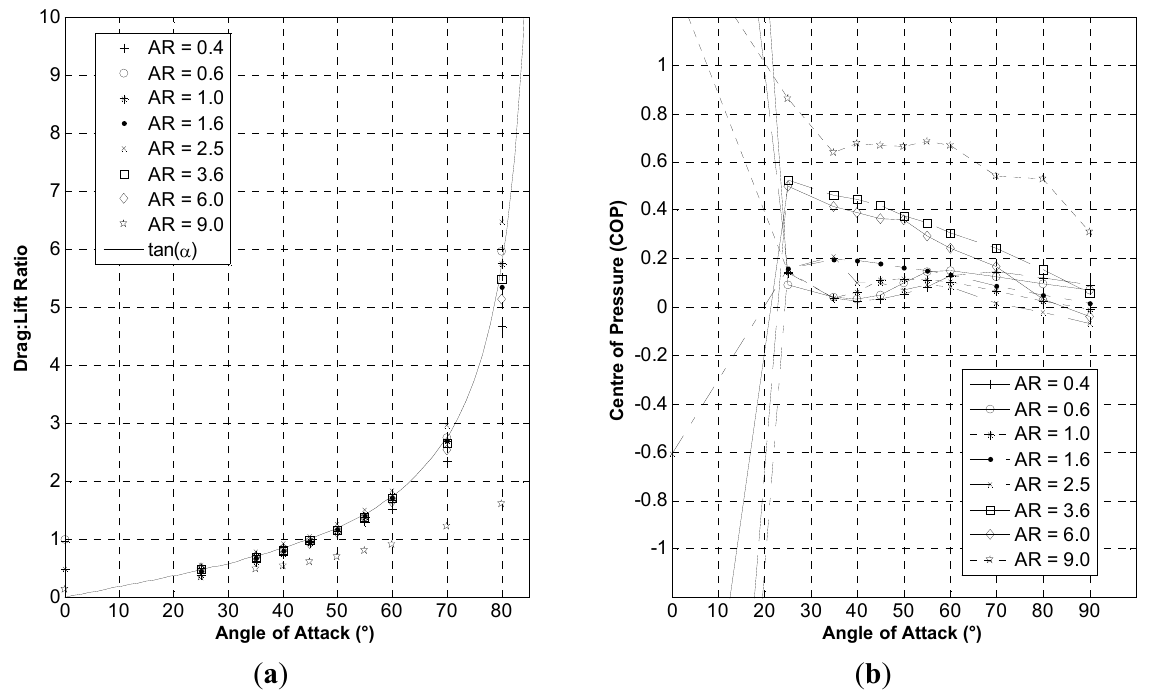
Figure 10. ( a ) Drag:lift ratio and ( b ) CoP at minimum clearance as a function of AR and α